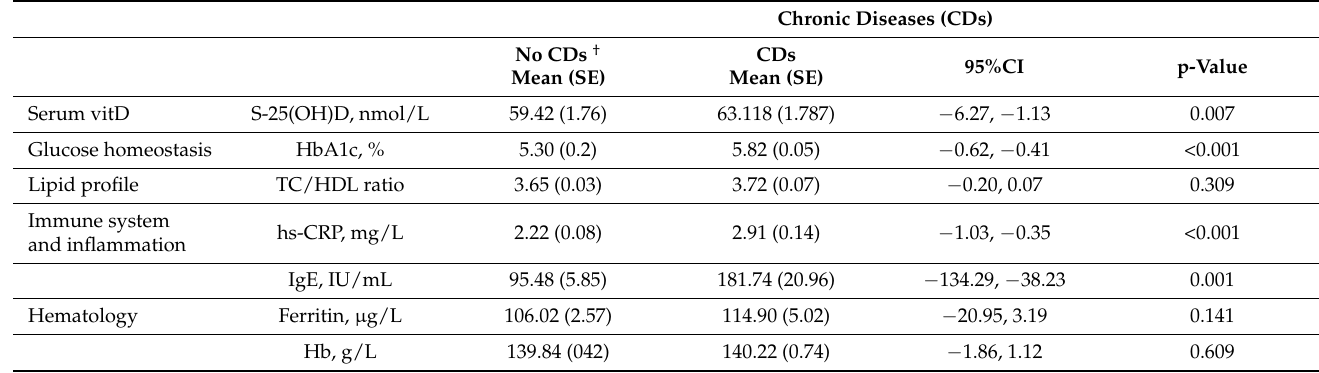
Table A6. Weighted means for biomarkers by the presence of chronic diseases.